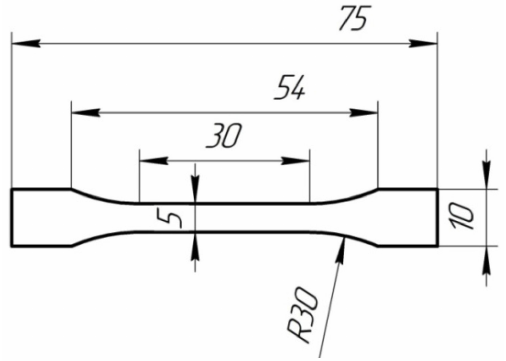
Figure 1. Scheme of the PLA film samples used for tests of mechanical